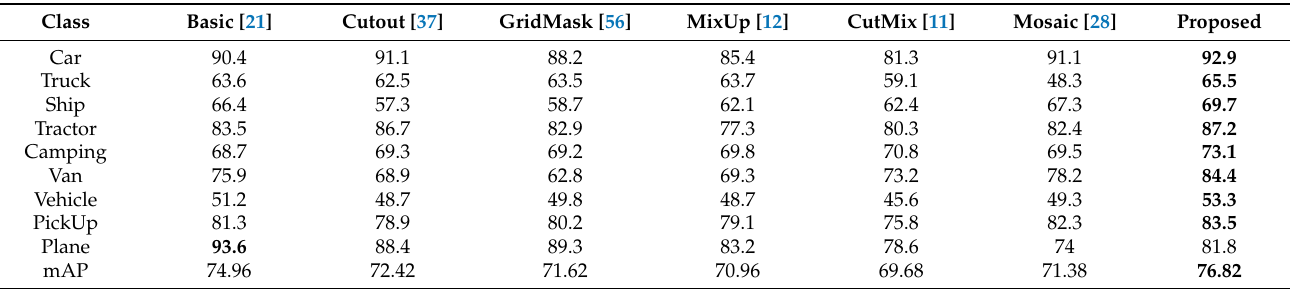
Figure 13. Detection result: Ground Truth (right), Mosaic (middle), Aggregated-Mosaic (left). Table 3. Results of VEDAI 1024.